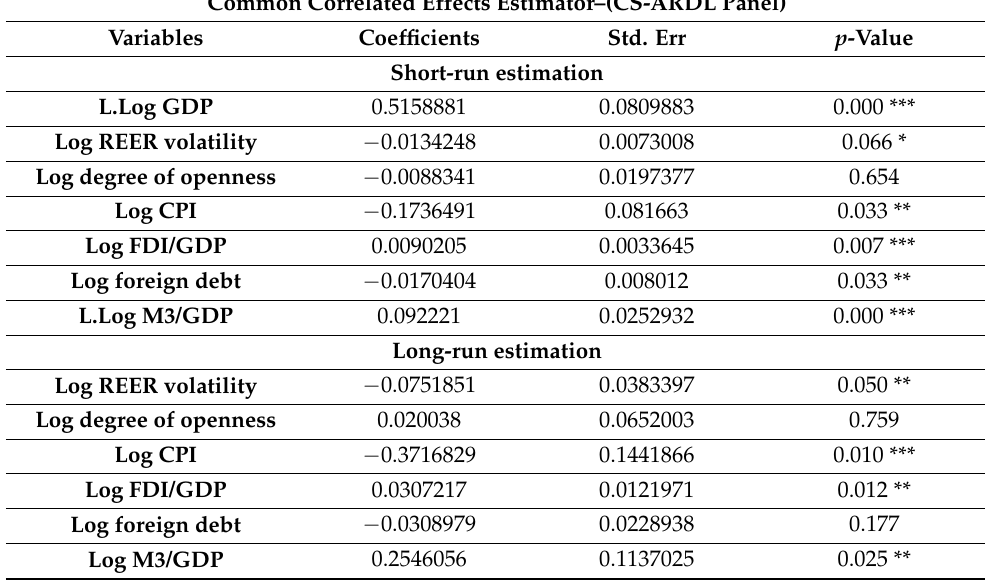
Table 11. Panel CS-ARDL estimation results. Common Correlated Effects Estimator–(CS-ARDL Panel)